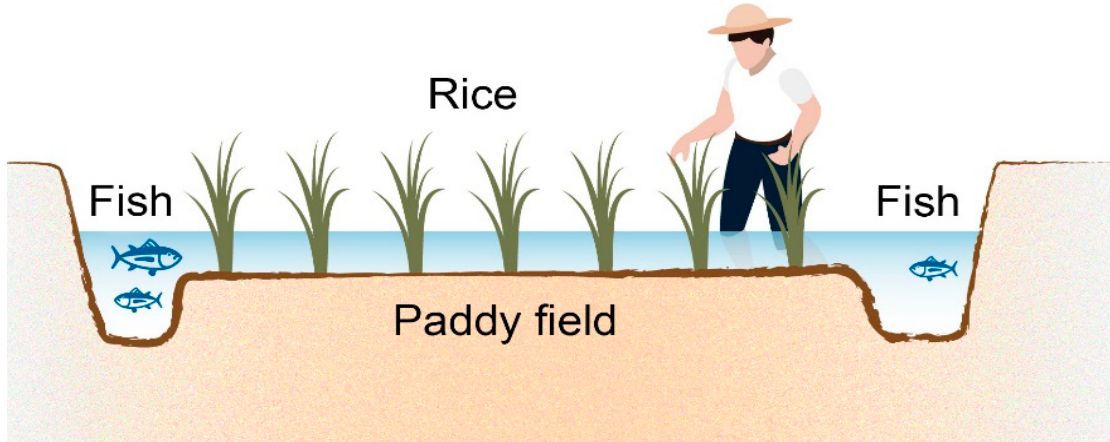
Figure 2. Integrated agriculture–aquaculture for rice–fish farming.